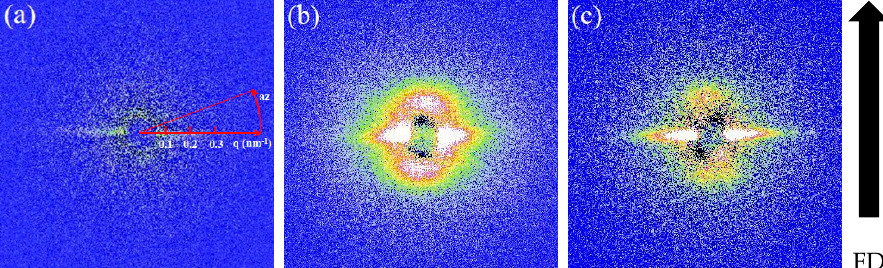
Figure 2. The 2D small-angle X-ray scattering (SAXS) patterns obtained immediately after flow with different durations of ( a ) 2, ( b ) 4, and ( c ) 6 s. The flow direction (FD) is vertical.